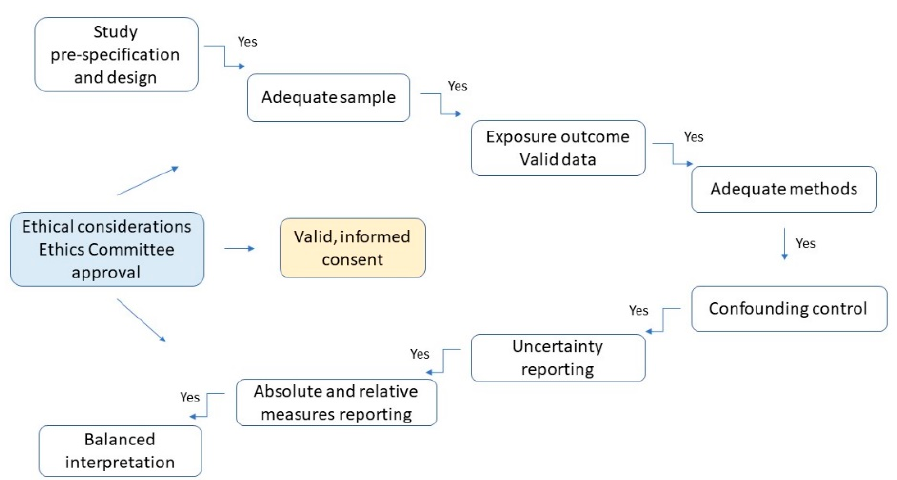
Figure 2. The verification process of prospective study credibility and protocol. Applied flowchart.